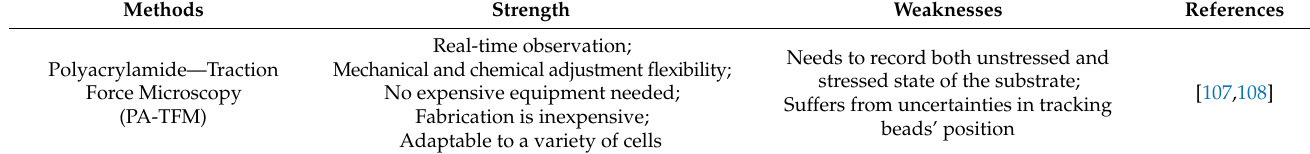
Table 1. Comparison of advantages and limitations in the techniques used for cell adhesion studies. Methods